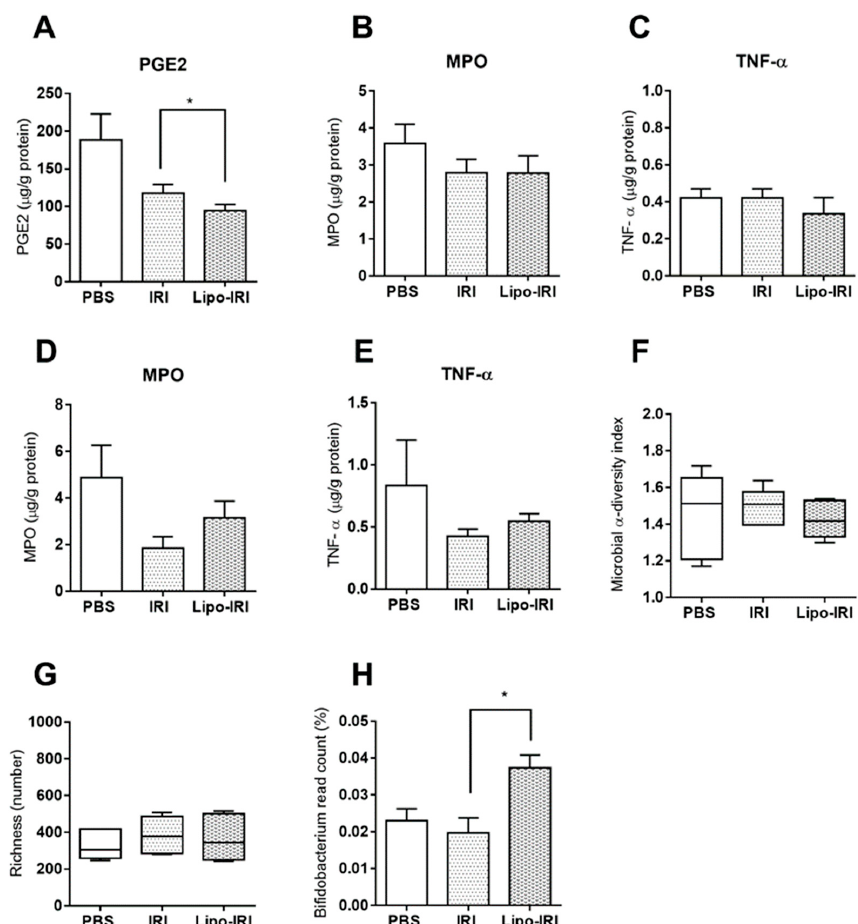
Figure 6. Quantification of inflammatory mediators in colon tissues and microbiota analysis in fecal samples. The colon tissues were harvested after the drug treatment and homogenates were assayed with sandwich ELISA for PGE2, MPO and TNF- α ( A , B and C , respectively). The MPO and TNF- α levels in the colon were assessed after four consecutive treatments ( D and E ). The microbiota diversity, richness, and Bifidobacterium spp. population are shown in ( F ), ( G ) and ( H ). Each column represents the mean ± SD ( n = 3). Compared to IRI, * p < 0.05.